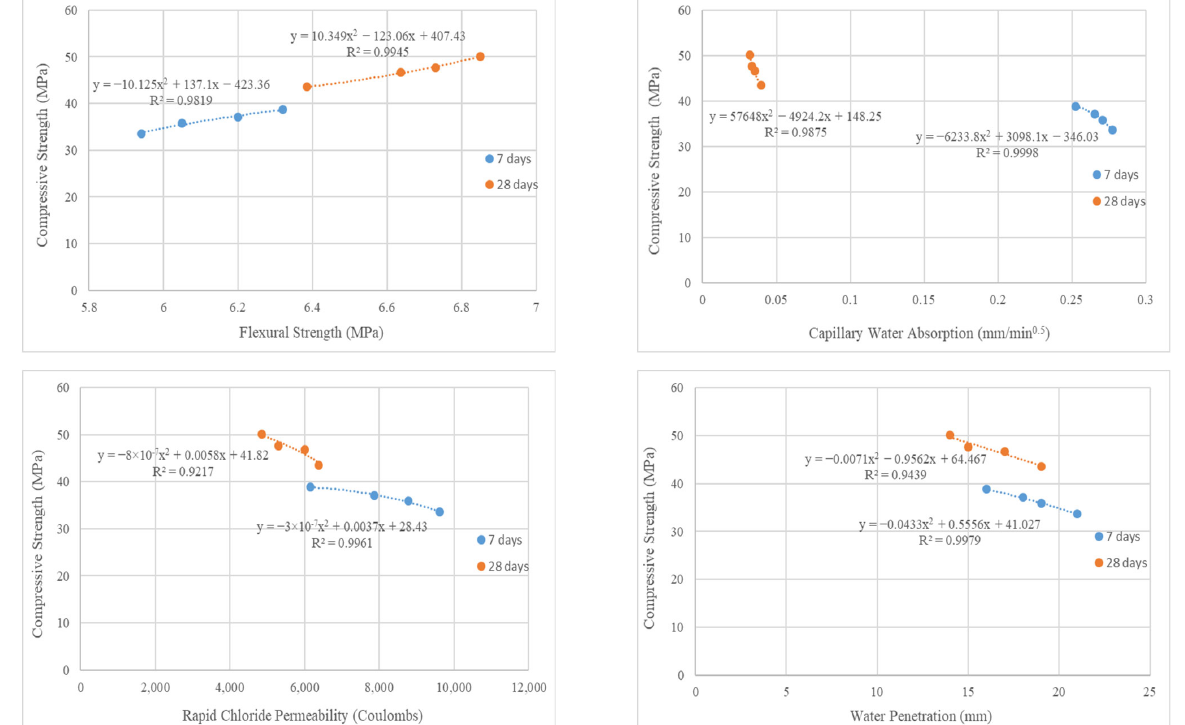
Figure 9. Correlation relations between mechanical and durability properties with compressive strength. Table 3. Correlation coefficients between mechanical and durability properties with compressive strength.